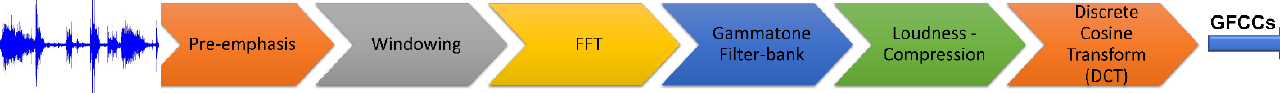
Figure 3. Block diagram of GFCCs feature extraction module.